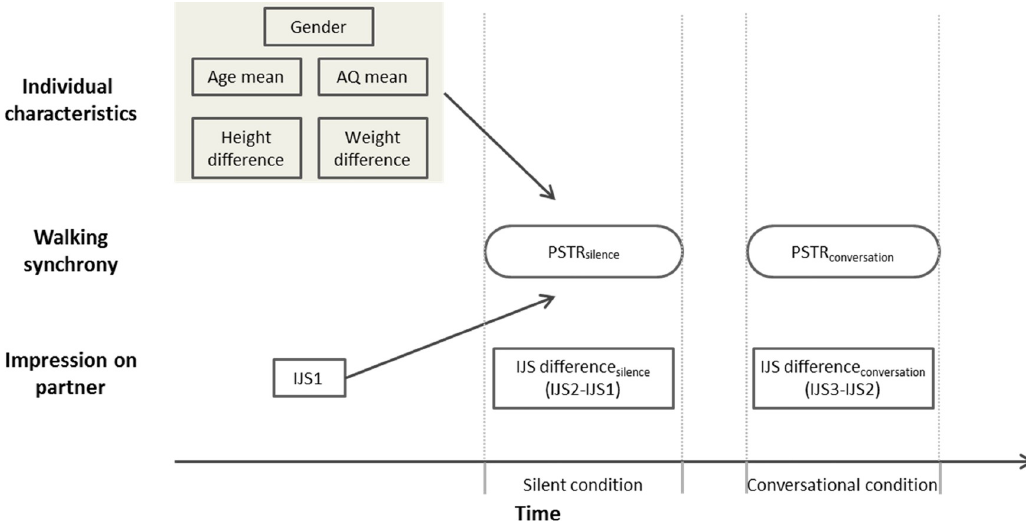
Fig 9. Possible factors that predicted the PSTR under the silent